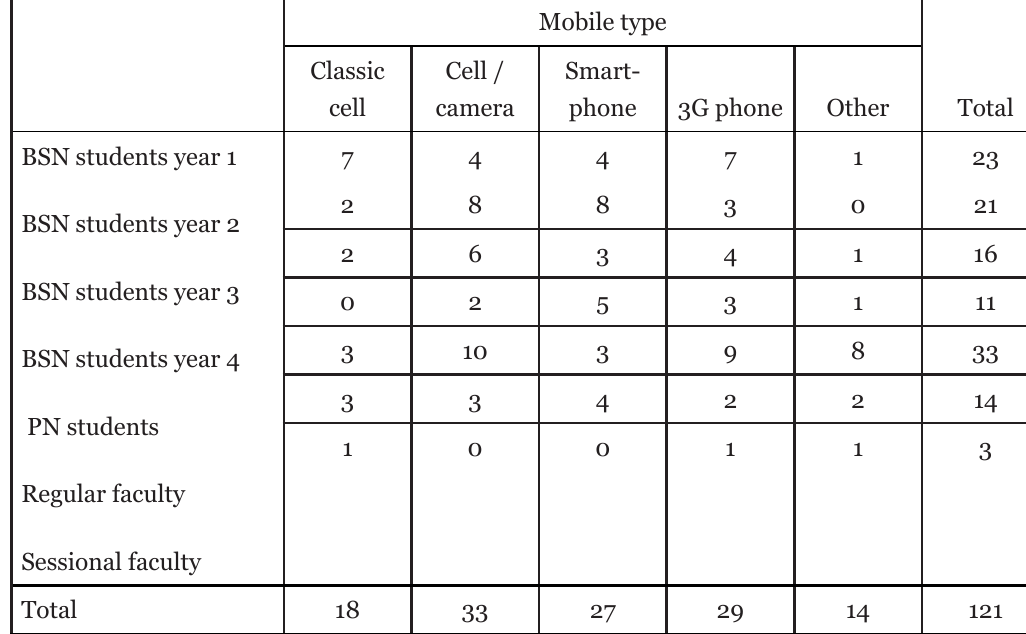
Type of Mobile Owned